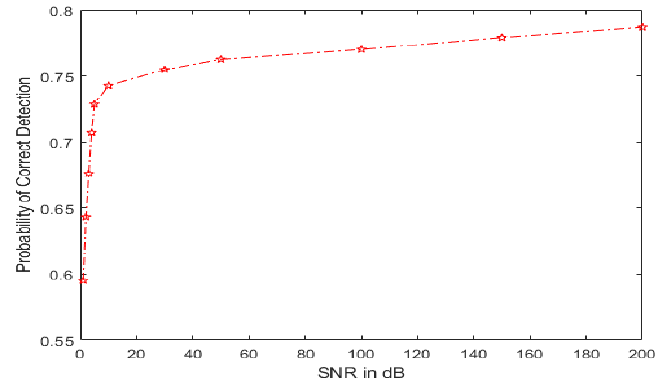
Figure 8. Probability of correct detection against SNR.